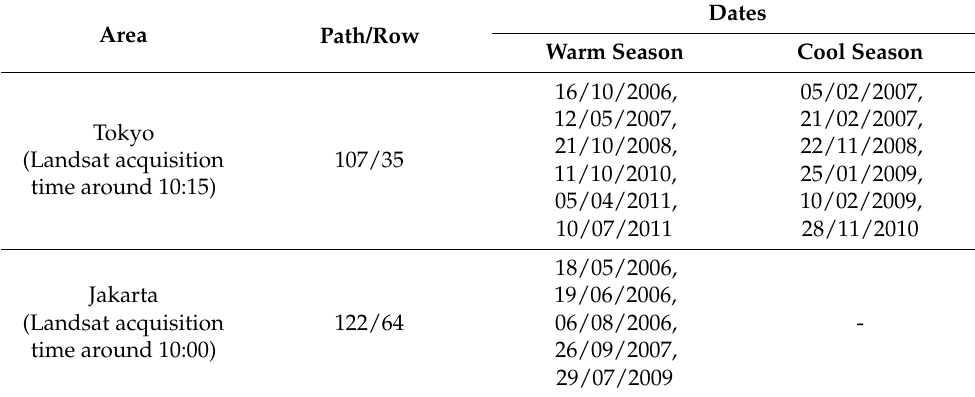
Table 2. Analyzed Landsat 5 data.